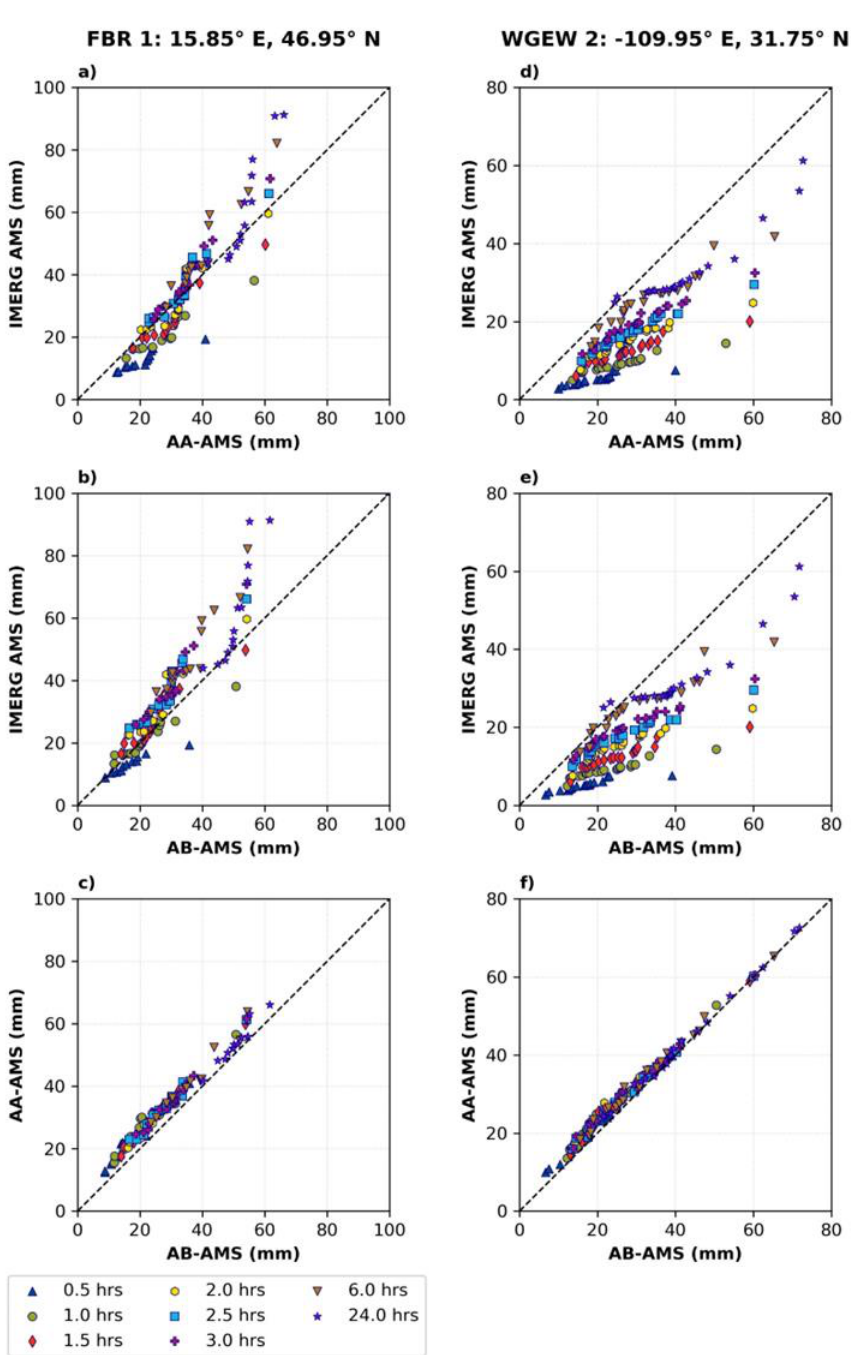
Figure A3. QQ-plots comparing the AMSs for FBR 1 ( left ) and WGEW 2 ( right ). From top to bottom: IMERG AMS vs. AA-AMS, IMERG AMS vs. AB-AMS, and AA-AMS vs. AB-AMS. The markers are the durations 0.5, 1, 1.5, 2, 2.5, 3, 6, and 24 h. The 45° dashed line is a reference line.